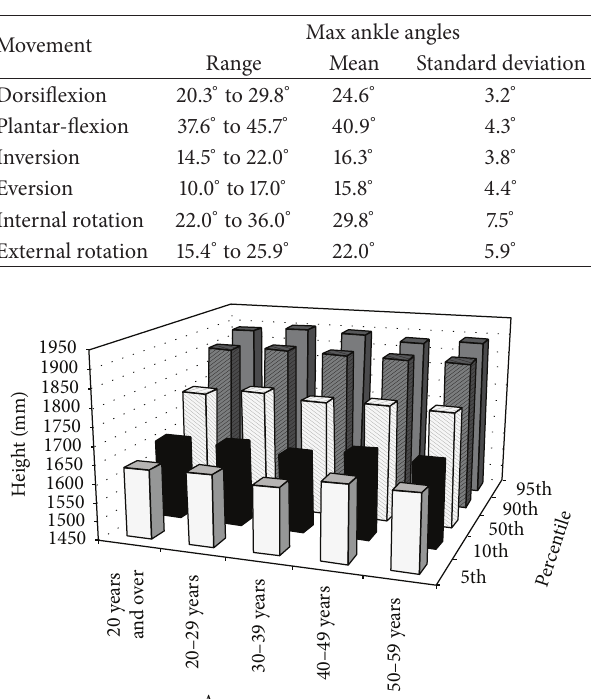
Table 1: Range of human ankle motion [10].